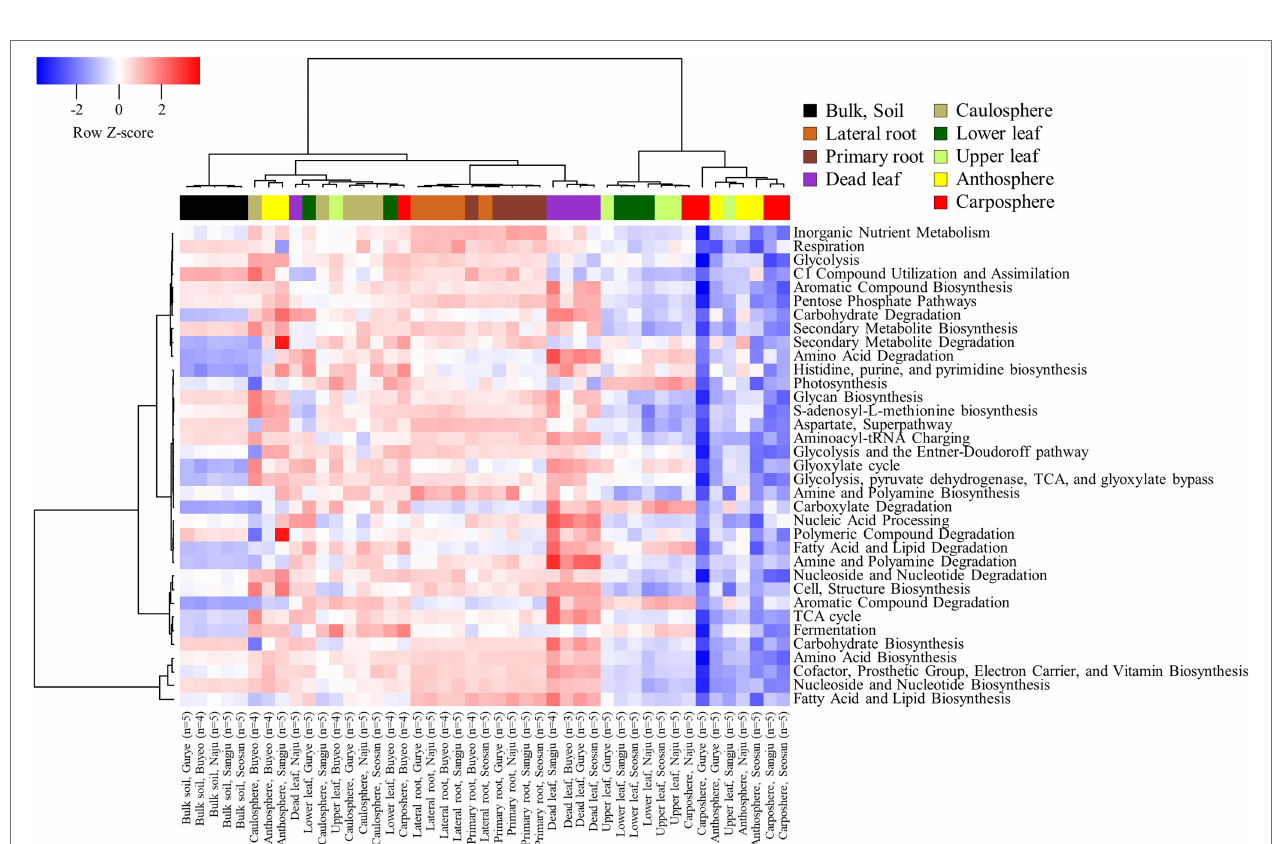
FIGURE 5 | Heatmap of hierarchical clustering of functional groups predicted by Picrust2